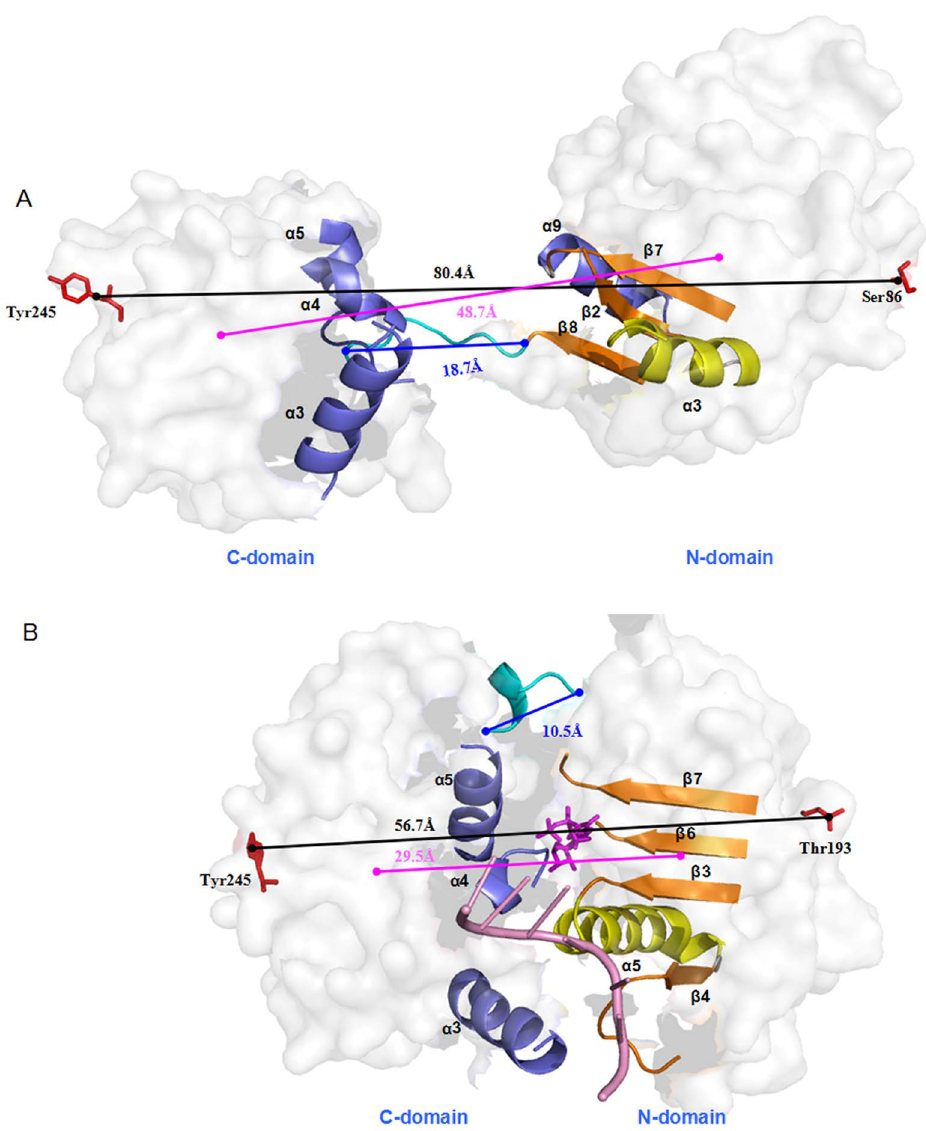
Figure 5. The distances in the open and closed eIF4A states. The length of whole eIF4A protein (black line), the mass center distance between two domains (magenta line) and the length of the linker (blue line) for (A) the open eIF4A state for the O-eIF4A model and (B) the closed eIF4A state in the ATP + RNA + C-eIF4A model; the a helices and b strands at the N-domain – C-domain interface are labeled and shown in cartoon form with the remaining part of the protein colored in white semi-transparent surface; the ATP and RNA molecules are shown by magenta stick and pink cartoon, respectively, in the closed state.